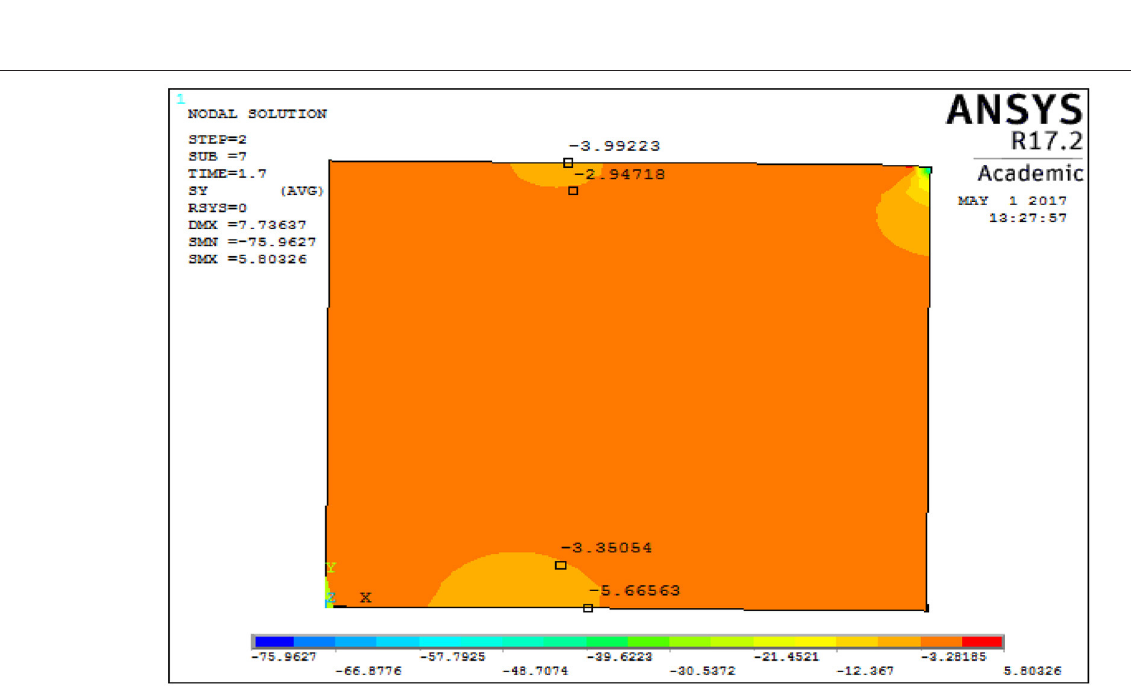
Frontiers in Built Environment | www.frontiersin.org